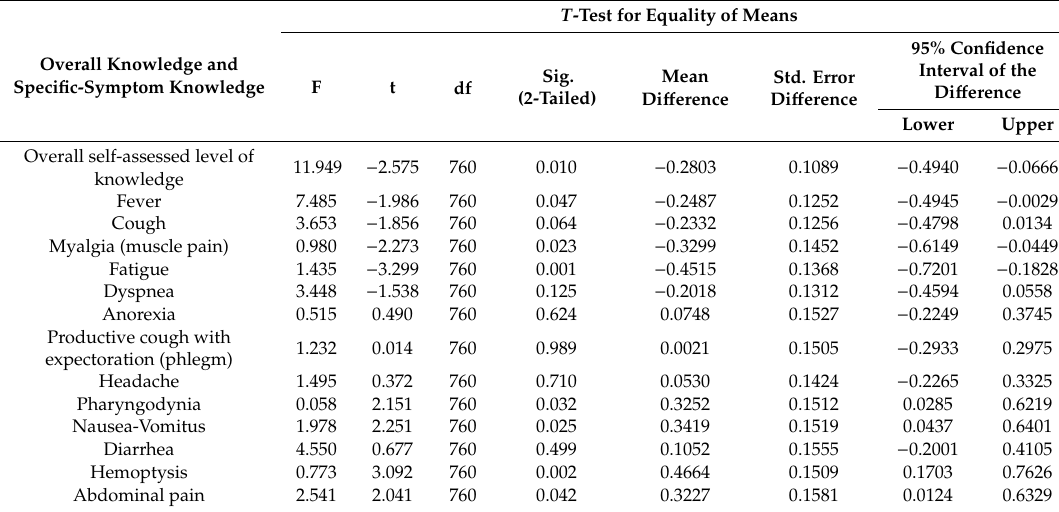
Table 6. Independent samples t -test between the Gen Z’ers gender and their self-assessed knowledge of the COVID-19 disease